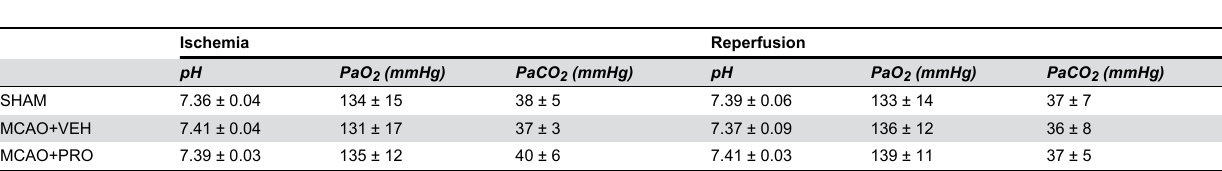
Table 3. Physiological variables during MCAO and